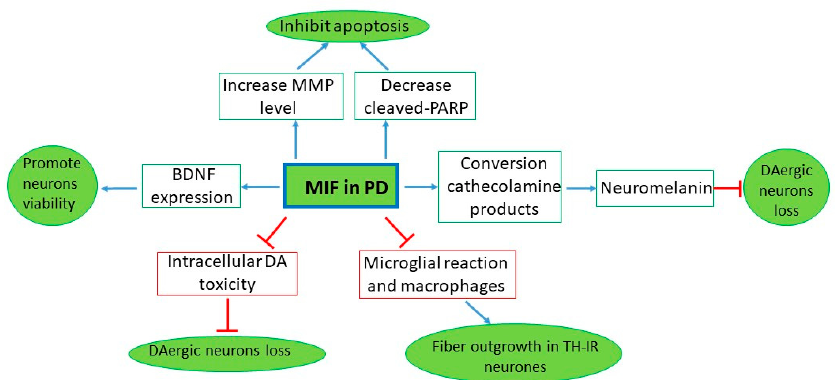
Figure 2. MIF in PD. Preclinical studies on MIF in PD, which show the results obtained in vitro and in vivo studies and the different pathway of how MIF could exert its protective function to inhibit neuronal loss. MIF mediates a neuroprotective effect via suppressing inflammatory responses, reducing the number of microglia and macrophages and displaying tyrosine hydroxylase-immunoreactive (TH-IR) neurons’ enhanced fiber outgrowth [49]. MIF also inhibits apoptosis and neuronal loss, detoxifying catecholamine-derived [15] and also promoting BDNF expression [50], increasing MMP and decreasing cleaved-PARP [47].